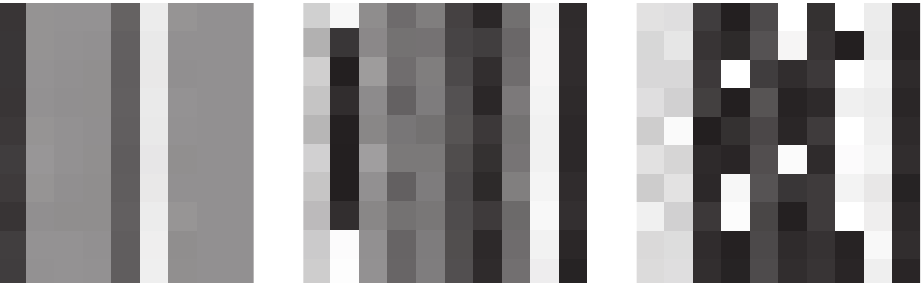
Figure 1. Received signal strength (RSS) grayscale under different labels (Labels from left to right are ‘2-2’, ‘2-6’, and ‘2-10’ respectively).